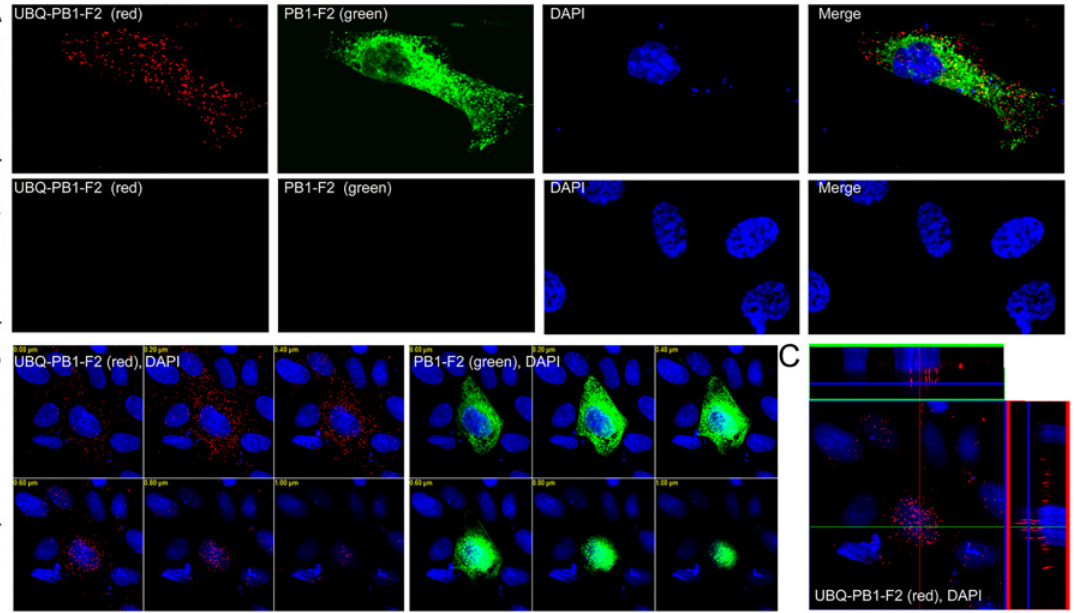
Fig 2. Detection of PB1-F2 ubiquitination using IF-PLA confocal microscopy. MDCK cells were transfected with 1 μ g of pPB1-F2 PR8 or pPB1-F2 Stop3aa as a negative control. At 24 hr p.t., (A) the subpopulation of ubiquitinated PB1-F2 (labeled UBQ-PB1-F2, red spots, upper left panel) was detected using a mixture of primary antibodies specific to UBQ and PB1-F2 and the PLA probes. In the same cell, PB1-F2 (green) was stained with a secondary antibody conjugated with FITC. Neither PB1-F2 nor UBQ-PB1-F2 was detected in the MDCK cells transfected with pPB1-F2 Stop3aa (lower row). (B) Z stacking was used to visualize UBQ-PB1-F2 (below left panel) and PB1-F2 (below middle panel) in multiple focal planes to measure the overall extent of the expression, ubiquitination and localization of UBQ-PB1-F2 or PB1-F2. (C) Orthogonal section reconstruction was applied to observe the subcellular localization of UBQ-PB1-F2 (lower right panel). The nuclei were stained with DAPI.